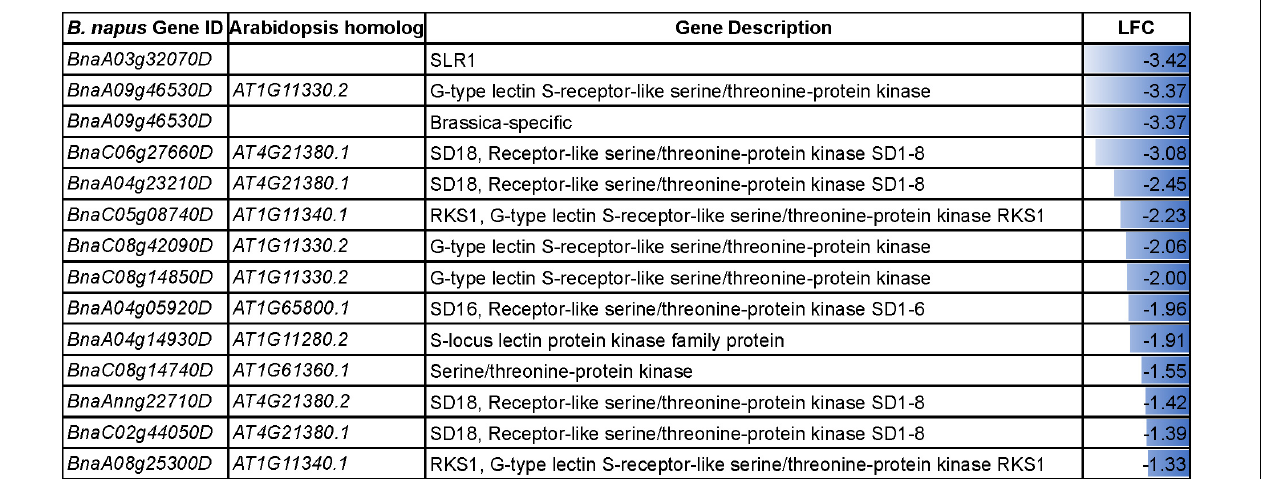
FIGURE 7 | Details of the DEGs associated with the GO terms “recognition of pollen” and “pollen-pistil interactions” in the heat-stressed pistil. LFC, log 2 foldchange.